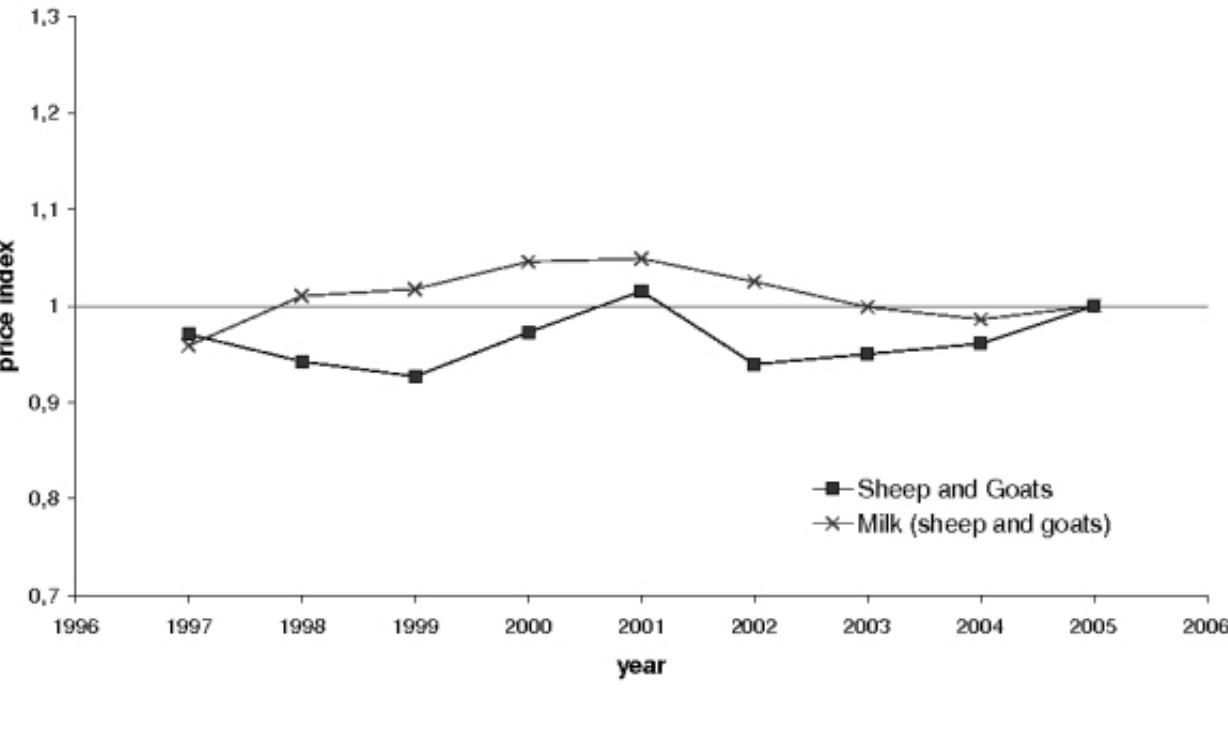
Figure 7. Deflated agricultural price indices for the main outputs of the livestock sector in Greece (reference year = 2005;